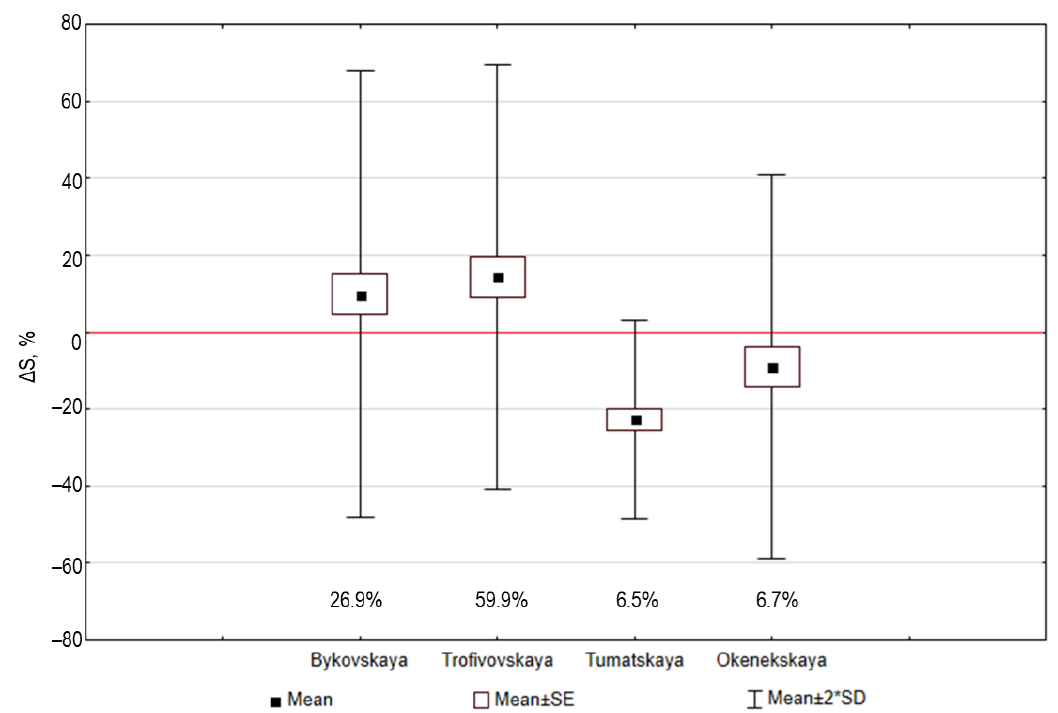
Figure 10. The suspended sediment changes ΔS (%) along the middle reach of the Lena River by relative discharges of the particular distributaries.